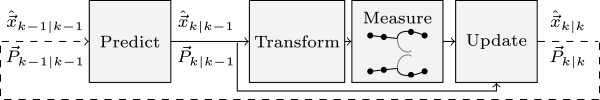
State estimation KF processing chain. Figure adapted from [6]. x^k|j and Pk|j denote the state and covariance estimates respectively, at time index k using measurements up to and including time index j.